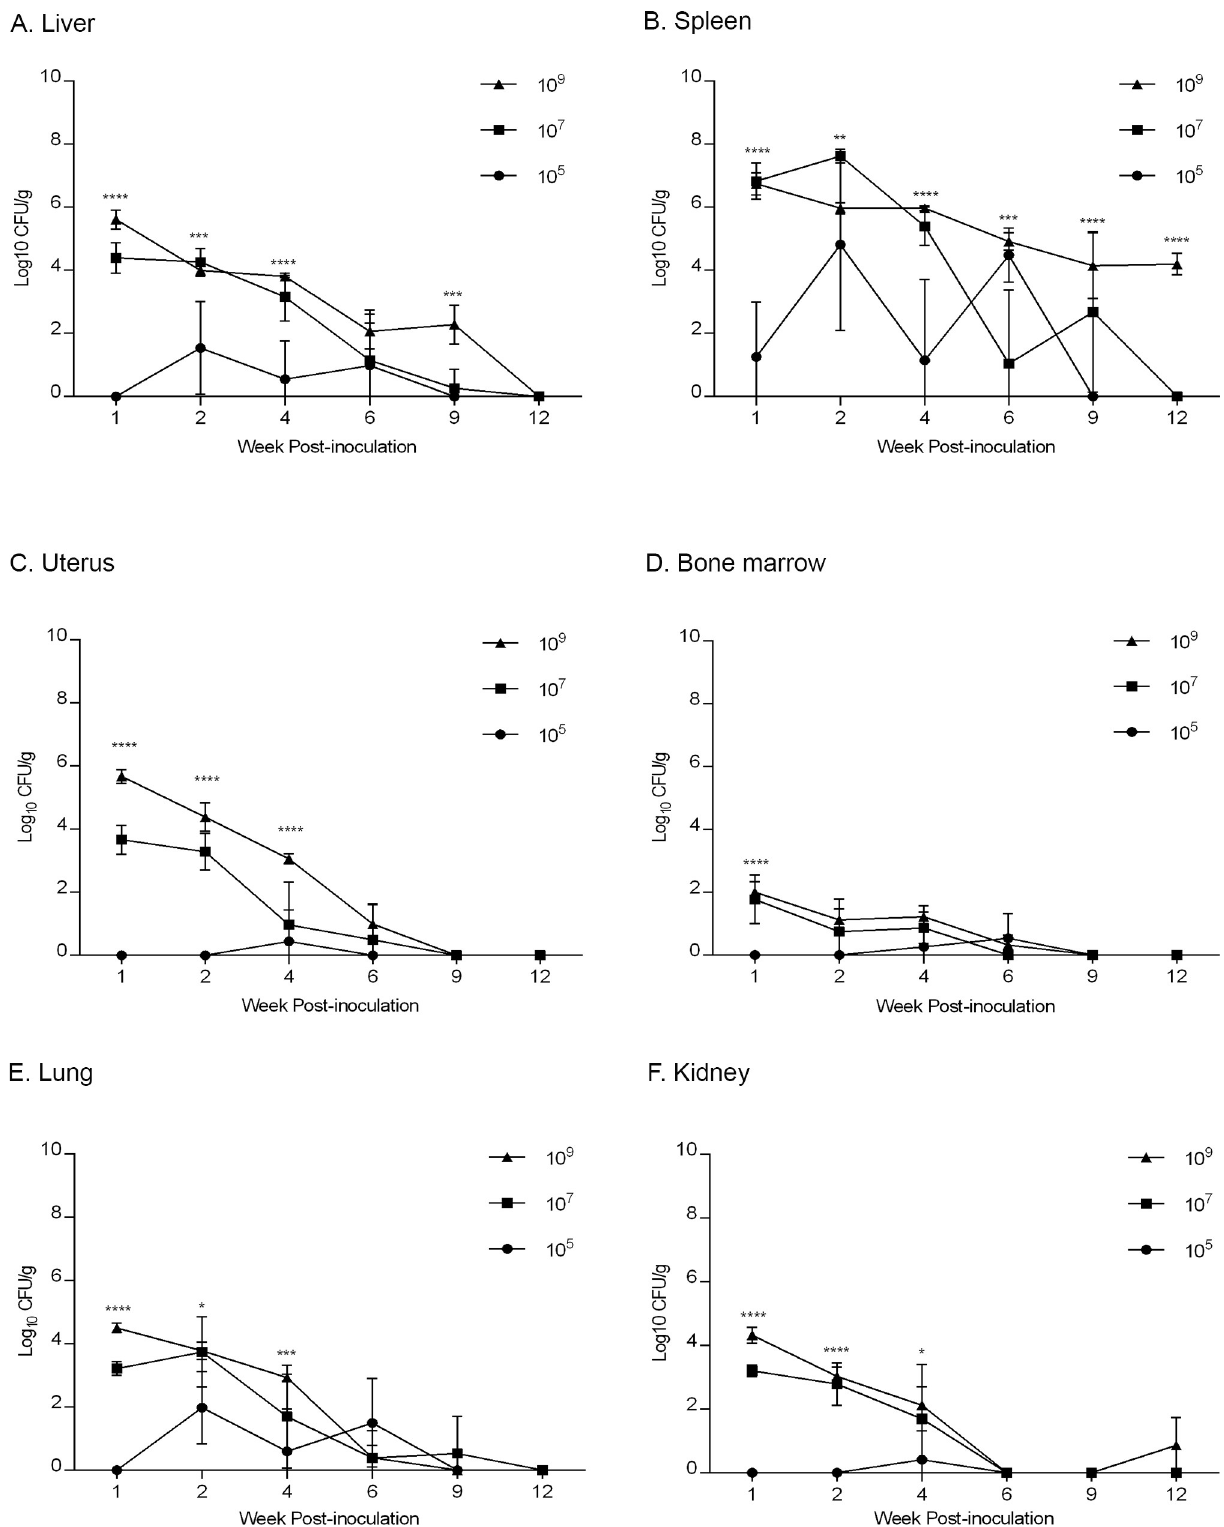
Fig 1. Kinetics of bacterial colonization of B . canis RM6/66 in mice. Animals were divided into 4 groups (n = 30) consisting of lower dose (10 5 , 10 7 ), high dose (10 9 ), or control (PBS) groups. Animals were inoculated i.p. and 5 animals from each group were euthanized at 1-, 2-, 4-, 6-, 9-, and 12-weeks